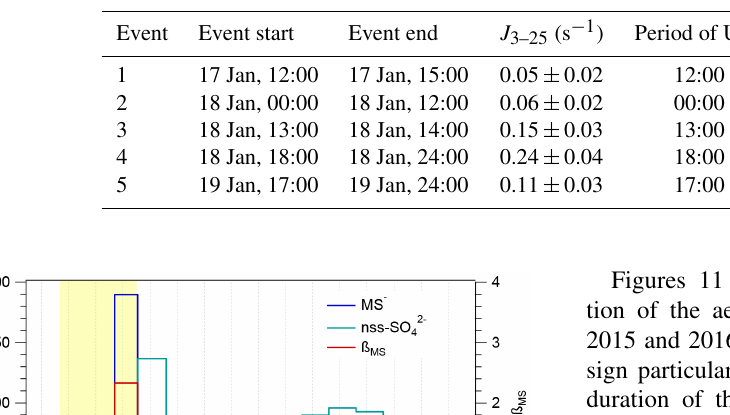
Table 3. List of distinct enhanced UCP concentrations and natural nucleation burst events apart from the main NPF (event numbers refer to Fig. 7). The initial nucleation rate (mean ± SD) is specified together with the period of the UCP 3–25 rise and the range of the particle diameter D p .